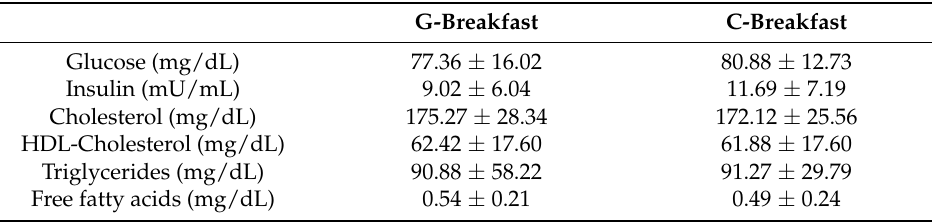
Table 2. Baseline characteristics at test